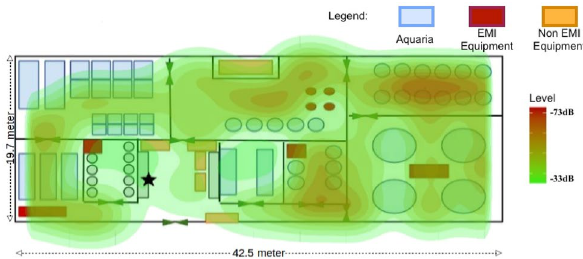
Fig. 8 Power consumption of temperature node in one cycle with